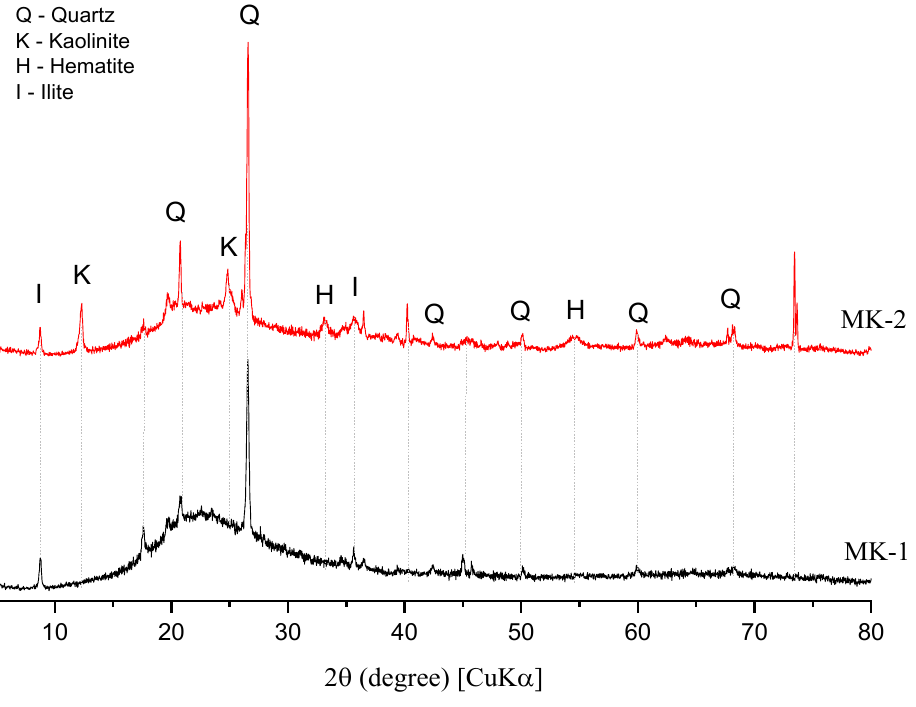
Figure 1. XRD spectra of MK1 and MK2.